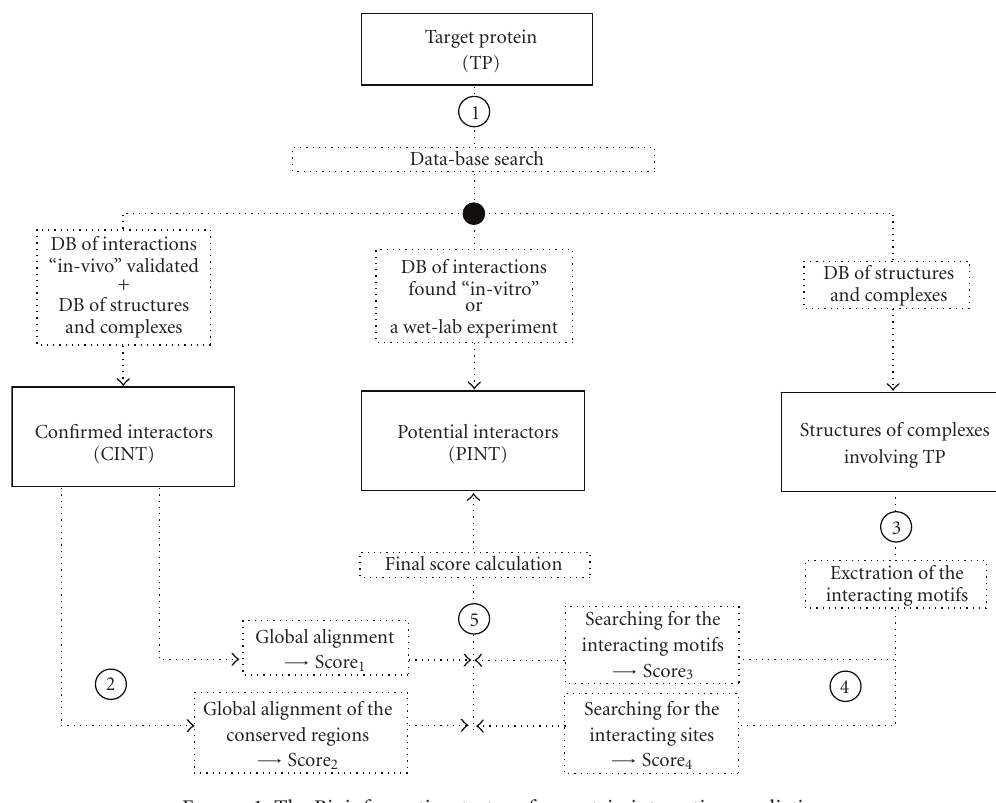
Figure 1: The Bioinformatics strategy for protein interaction prediction.